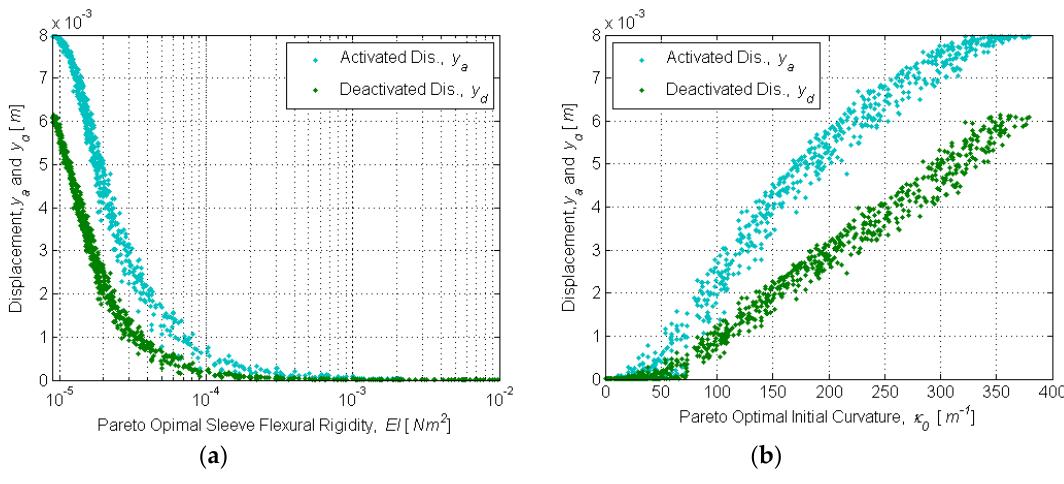
y ) and deactivated ( y ) a d . 0